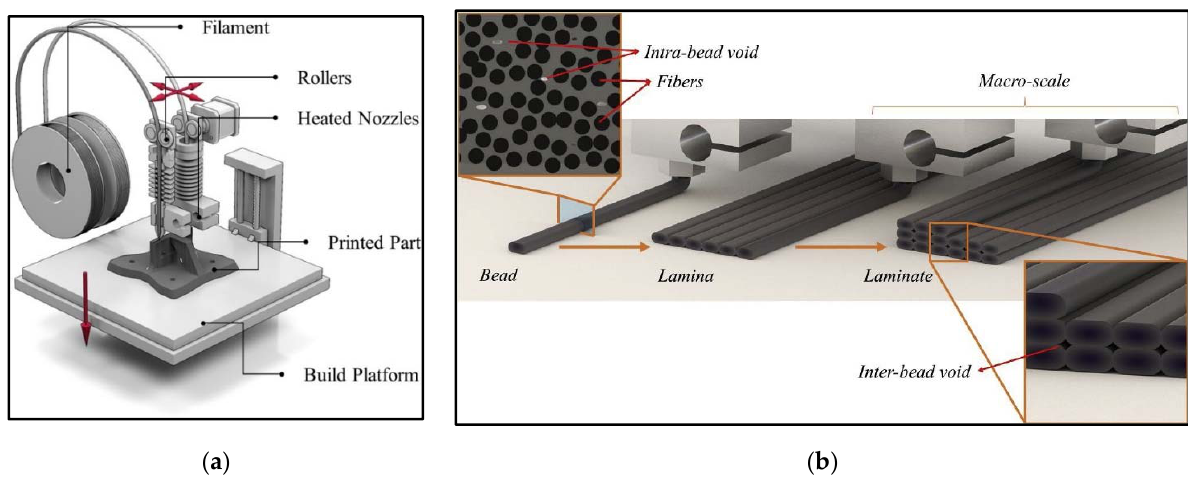
Figure 12. ( a ) Schematic illustration of conventional FDM Processes; ( b ) structural illustration of the FRP-printed part [54] (reprinted with kind permission from Elsevier).